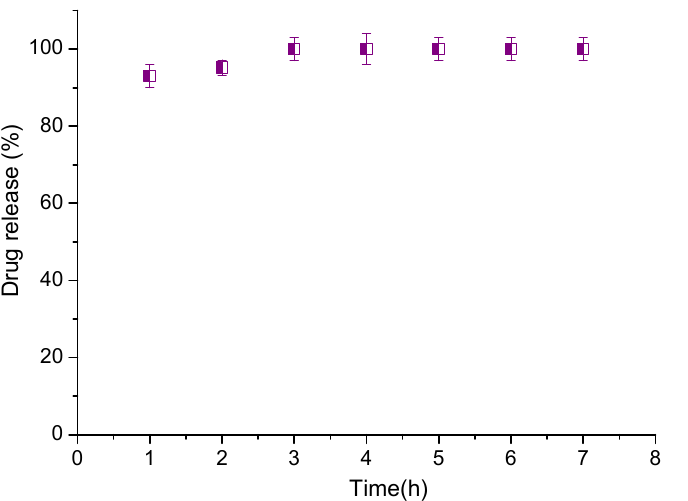
Figure 6. Simultaneous in vitro release of CAPE from crosslinked micelles in weak acidic medium pH = 5, after treatment with DTT.